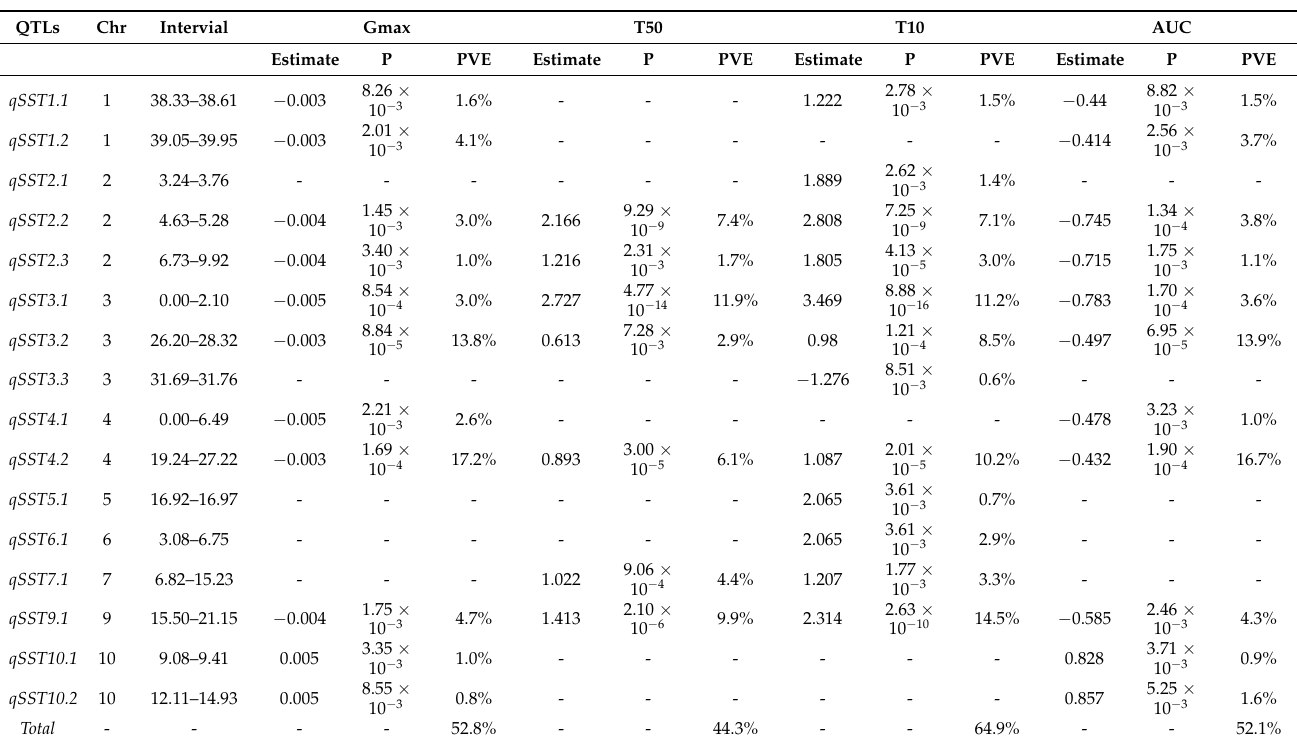
Table 1. QTLs identified for four germination parameters in the NIP/ZS97 CSSL population using the single nucleotide polymorphism (SNP) bin markers.